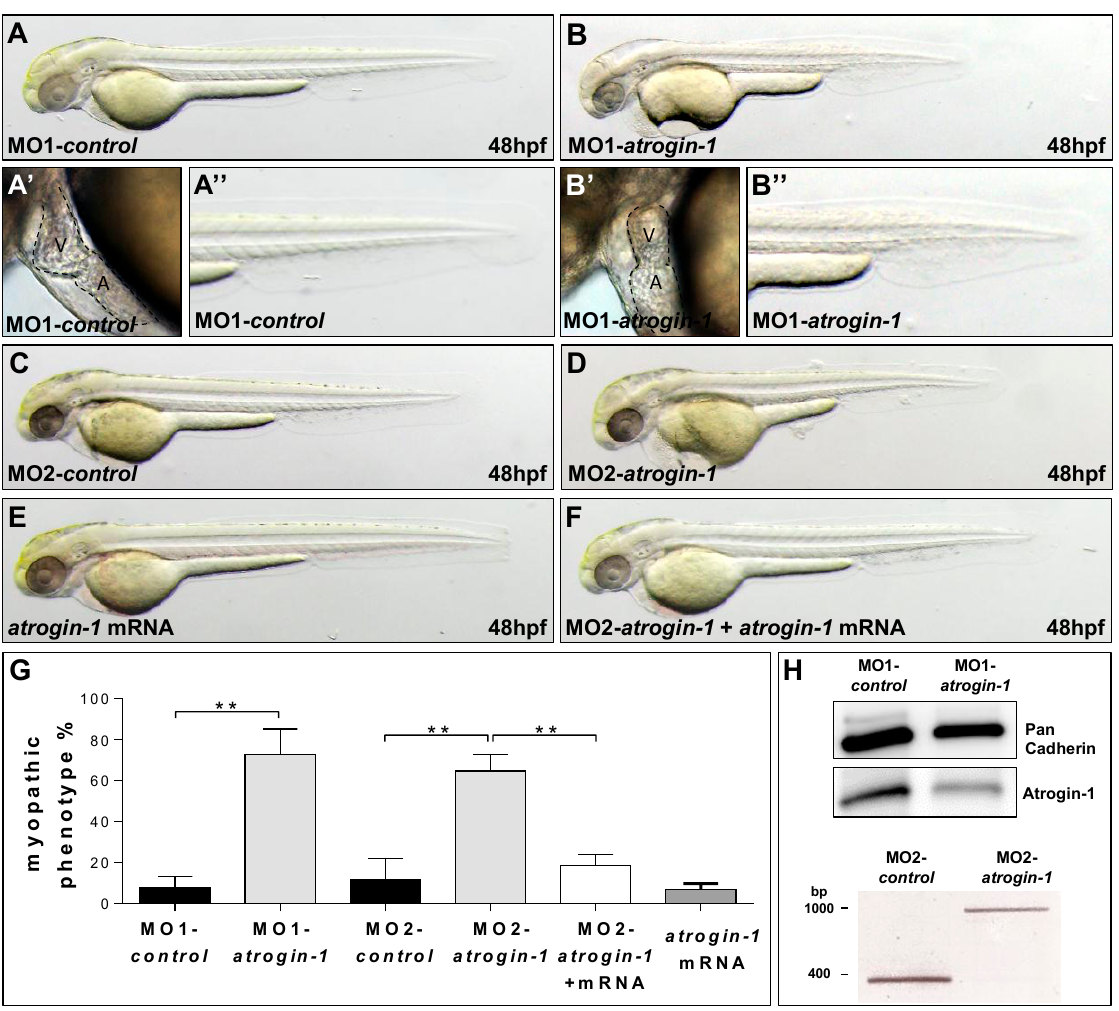
Figure 2. Knock-down of Atrogin-1 leads to defects in muscle and heart morphology. ( A , B ) Lateral view of embryos at 48 hpf injected either by 5 bp mismatch Start Morpholino (MO1- control , A ) or Start Morpholino directed against atrogin-1 (MO1- atrogin-1 , B ); ( A’ , A’’ – B’ , B’’ ) Close-ups of heart and tail of injected embryos at 48 hpf; ( C , D ) Lateral view of embryos at 48 hpf either injected by a 5 bp mismatch Morpholino targeting a splice donor site of Atrogin-1 as a control (MO2- control ) or a Splice Morpholino (MO2- atrogin-1 ); ( E , F ) Lateral view of embryos at 48 hpf. Control injection with atrogin-1 mRNA ( E ); Rescue of the morphant phenotype by injecting atrogin-1 mRNA and MO2- atrogin-1 together ( F ); ( G ) Statistical analysis of affected embryos after MO1/2- control , MO1/2- atrogin-1 , atrogin-1 mRNA or MO2- atrogin-1 and atrogin-1 mRNA. Data represent means ± SD, student’s t -test, ** p -value < 0.0022; ( H ) Western Blot analysis using an Atrogin-1-specific antibody after MO1- control and MO1- atrogin-1 injection, RT-PCR after injection of MO2- control , or MO2- atrogin-1 showing specific effect of MO injection. Atrium (A) and ventricle (V).